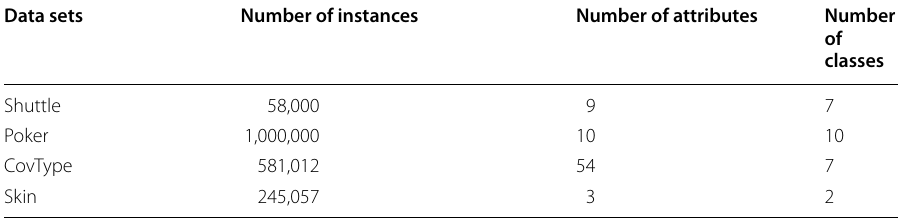
Table 5 The basic information of the 4 data sets